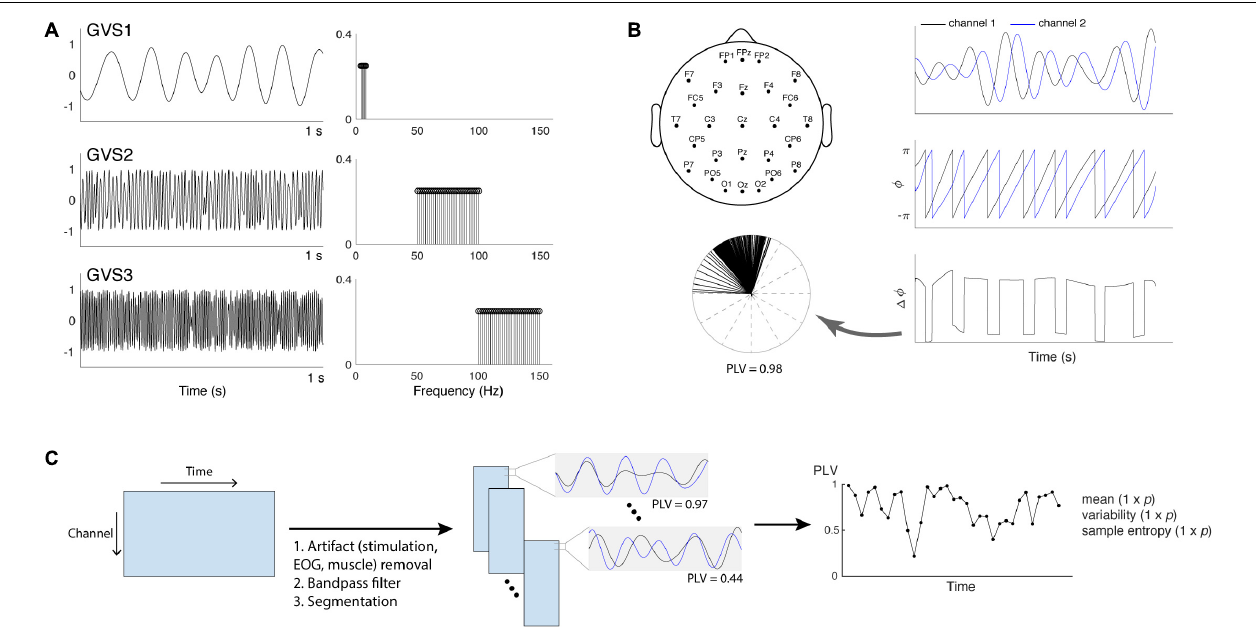
FIGURE 1 | (A) Time and frequency plots of the three types of multisine stimulus given at 90% individual threshold level (EVS1: 4–8 Hz; EVS2: 50–100 Hz; EVS3: 100–150 Hz). (B) Placement of 27 EEG electrodes and PLV calculation. Hilbert transform is applied to the two signals to extract the instantaneous phases. The phase differences calculated at each time point are represented into unit vectors in the complex plane and PLV is computed to evaluate the spread of the distribution (Lachaux et al., 1999; Mormann et al., 2000). (C) The procedure to extract phase locking value (PLV) time series. For each subject, preprocessing steps were first applied to the raw EEG data in order to remove high-voltage stimulation artifacts as well as cardinal artifacts caused by eye movements [electrooculography (EOG)] or muscle movement. The cleaned data were bandpass filtered into four different frequency bands (theta: 4–8 Hz; alpha: 8–13 Hz; beta: 13–30 Hz; gamma: 30–45 Hz) and segmented into epochs. PLV between a pair of electrodes in each epoch was computed to generate the time series, and its mean, variability, and sample entropy were calculated. Each subject has a 1 × p vector for the mean, variability and sample entropy ( p = 1,404 = 351 pairs × 4 frequency bands).